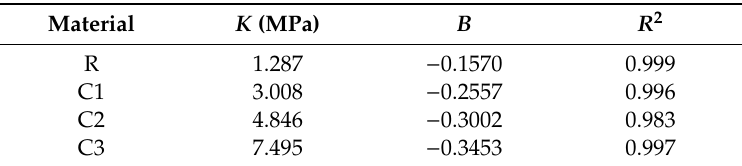
Table 4. Fitting constants of the Basquin equation.